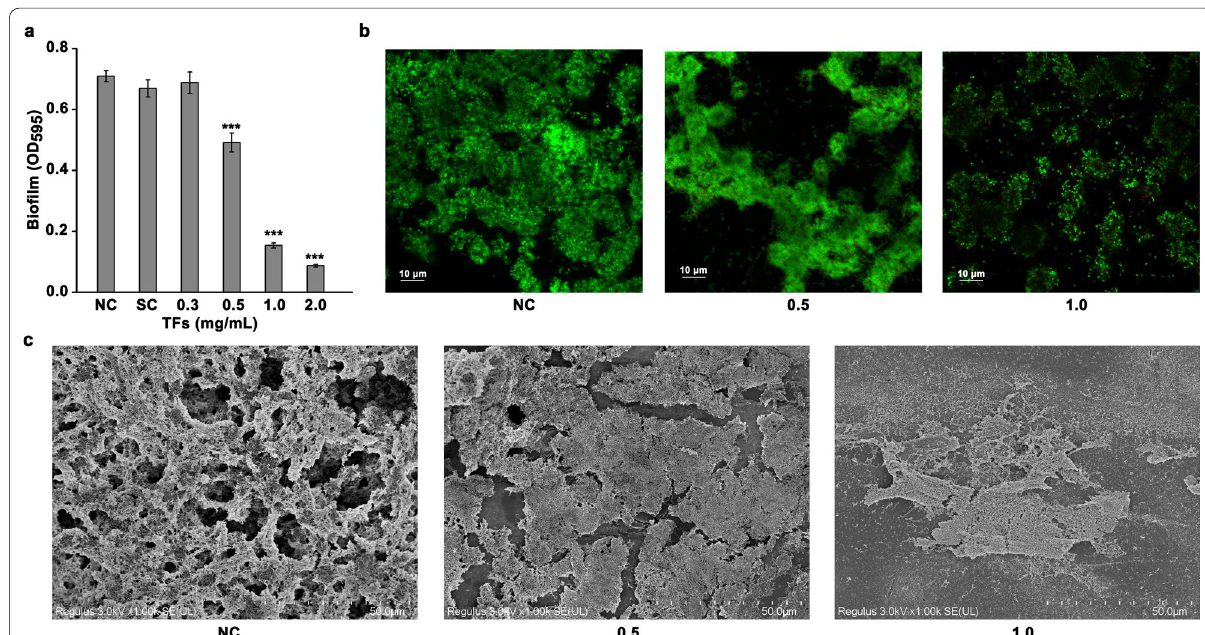
Fig. 3 Assay of the biofilm formation by S. mutans UA159. a Inhibitory effect of TFs on the biofilm formation quantified by crystal violet staining assay. Data obtained from three biological replicates were shown as mean standard deviation. “*” represents that there is a significant difference ± between two studied groups (*** p < 0.001). The difference was compared between the group with TFs added and the NC. Representative images showing the inhibitory effect of TFs on the biofilm formation by using confocal laser scanning microscopy ( b ) and a scanning electron microscope ( c ). The live and dead cells could be stained by SYTO ® 9 and propidium iodide (PI) nucleic acid stains,